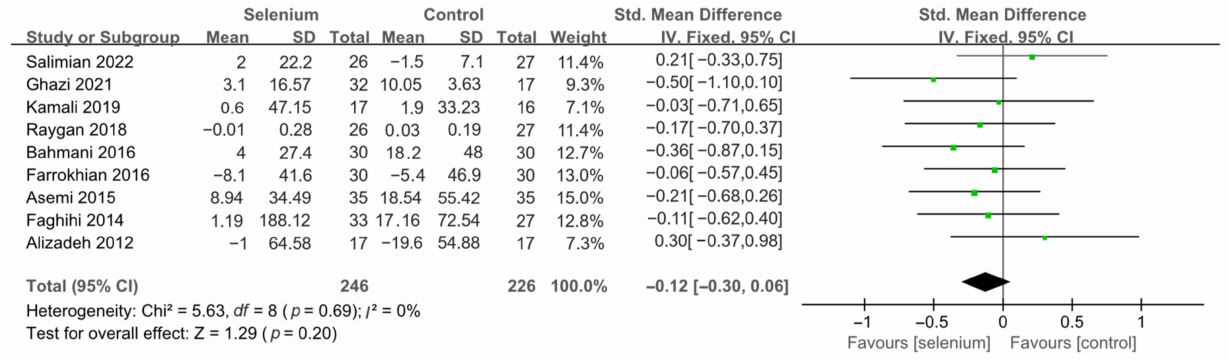
Figure 10. Forest plot of TG [30,41,42,44–49].